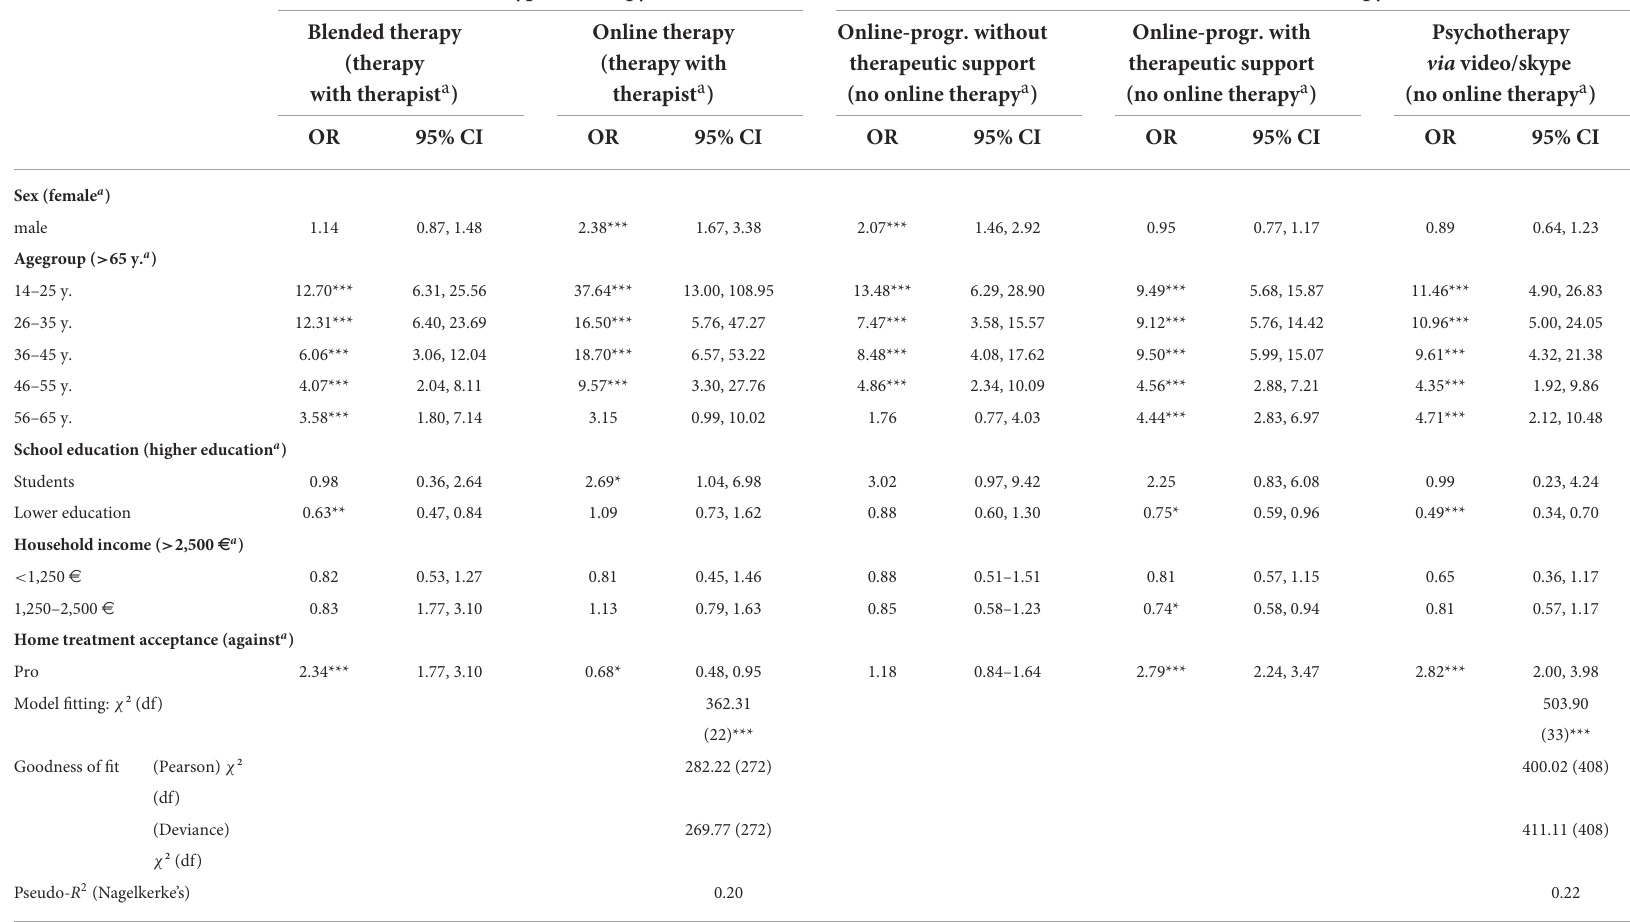
TABLE 3 Factors associated with attitudes toward online-therapy: multinomial logistic regressions. Item I: Type of